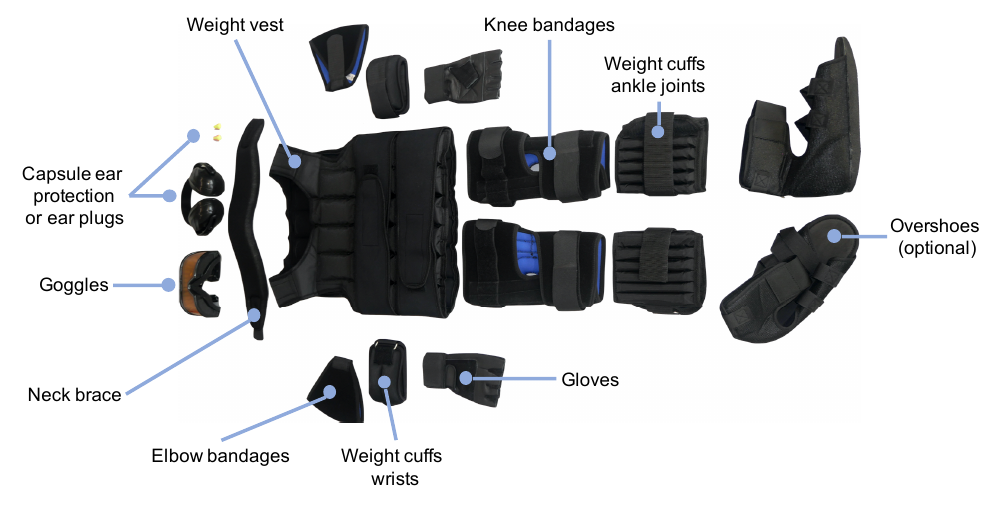
Figure 1. The age simulation suit